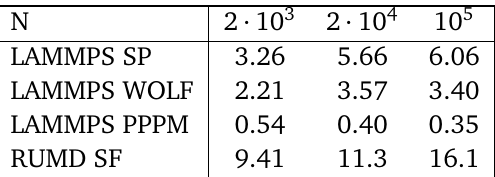
Table 4: Benchmarks for a system of charged Lennard-Jones particles (see text for details) for LAMMPS (CPU) and RUMD (Gtx 780Ti). The metric shown is MATS (millions of atom time steps per second). LAMMPS benchmarks were performed on a Dell 630 server with dual Intel Xeon E5-2699 v3 2.3 GHz CPU’s for a total of 36 cores. Coulomb interactions were evaluated using a simple shifted-potential cutoff at distance 6.0 (“SP”), using the Wolf method [ 56 ] with the switching parameter α set to zero (“WOLF”, equivalent to the shifted force method), and the Particle-Particle Particle-Mesh method (“PPPM”). RUMD benchmarks were performed on an nVidia GTX 780 Ti, using a shifted force cut-off (SF) at distance